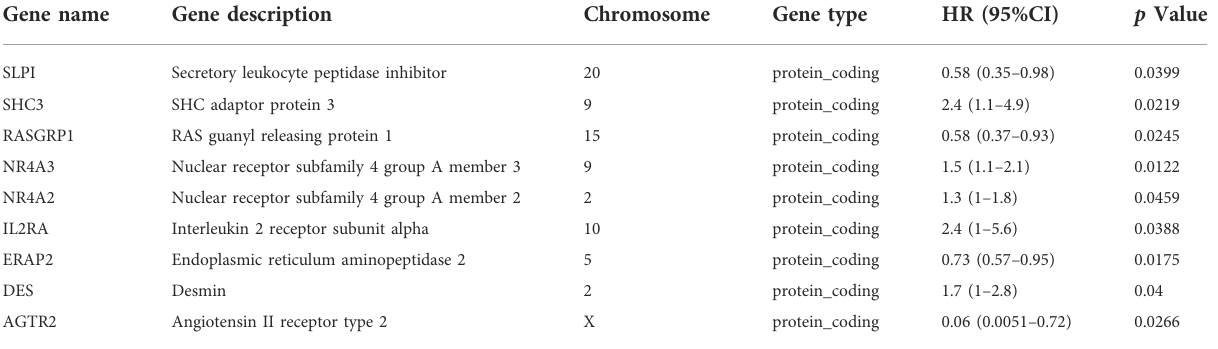
TABLE 2 Gene descriptions and univariate Cox regression of nine prognostic immune-related